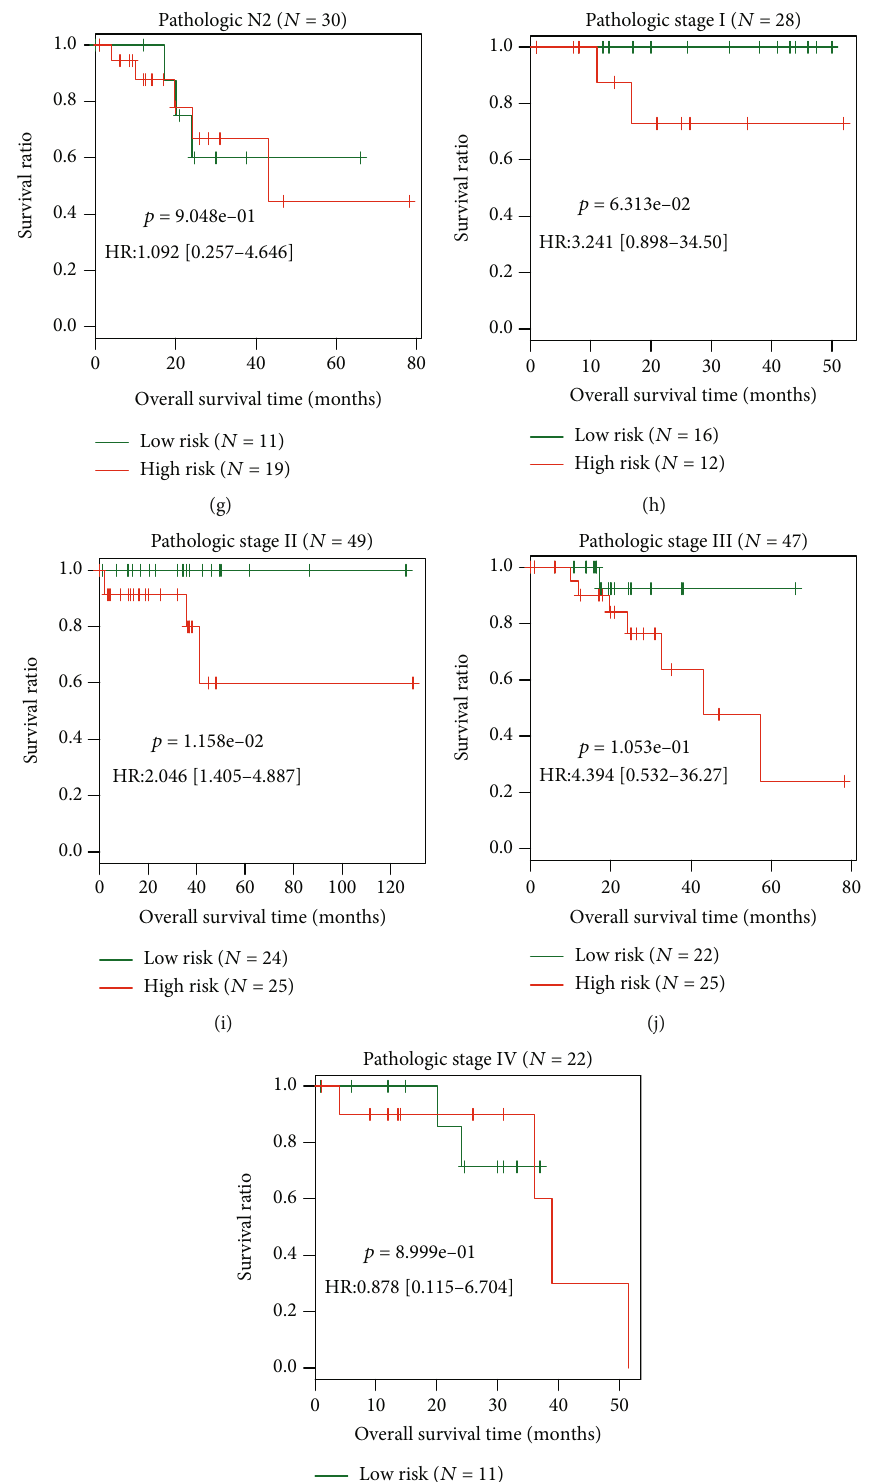
Figure 5: Risk strati fi cation models based on age, pathologic M, pathologic N, and pathologic stage. (a, b) Age strati fi cation ( > 65 years and < 65 years). (c, d) Pathologic M strati fi cation (M0 and M1). (e – g) Pathologic N strati fi cation (N0, N1, and N2). (h – k) Pathologic stage strati fi cation (I, II, III, and IV). HR: hazard